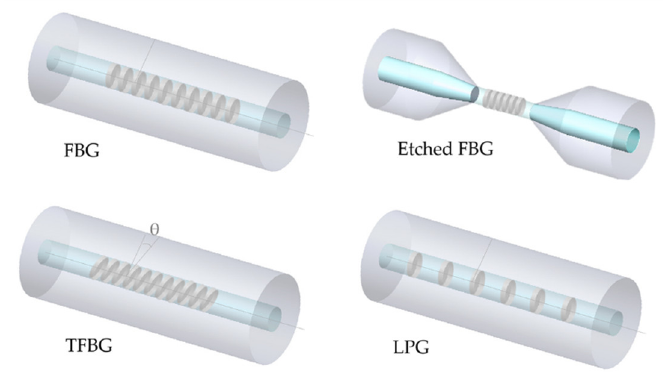
Figure 4. Schematization of grating-based OF configurations .